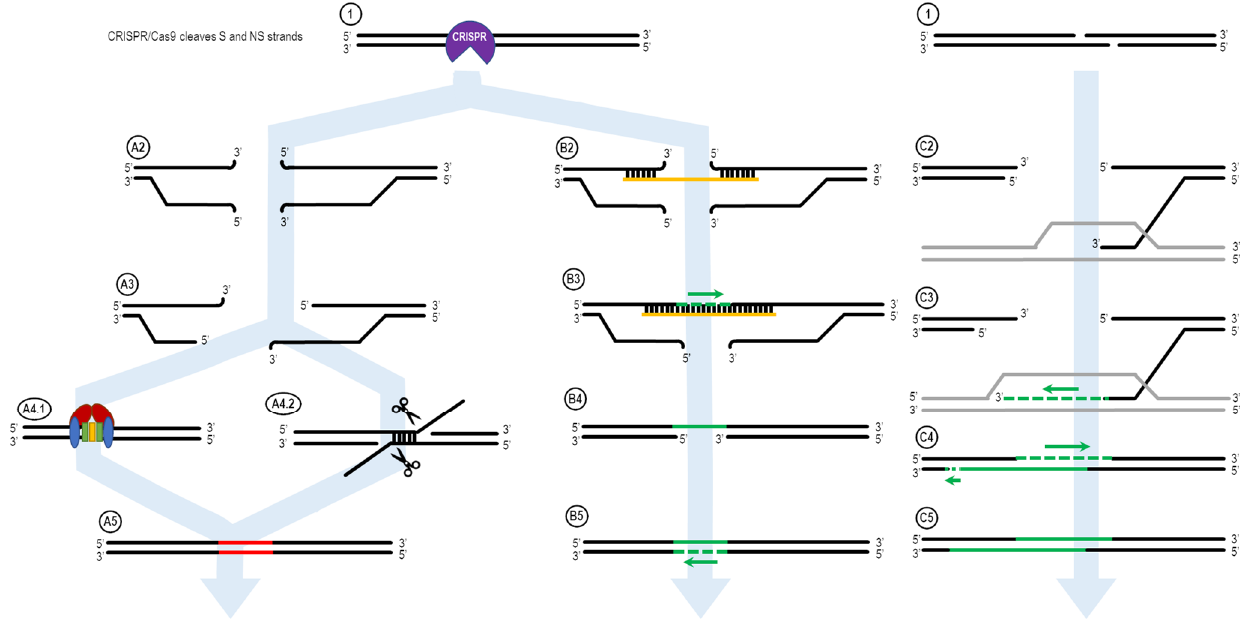
Figure 1. The ExACT DNA repair pathway, as outlined by Rivera-Torres et al. Upon CRISPR-mediated cleavage or breakage of the DNA ( 1 ), several possible pathways may be undertaken in order to facilitate DNA repair. In the absence of an ssODN oligo, or if the ssODN is not in the local vicinity of the broken DNA ends, the non-oligo repair pathway ( A2 – A5 ) is used. The CRISPR-Cas complex dissociated from the DNA ends ( A2 ), and resection of the DNA ends may occur ( A3 ). Then, either nonhomologous end joining (NHEJ, A4.1 ) or microhomology-mediated end joining (MMEJ, A4.2 ) occurs to repair the broken DNA ends. This results in an indel in the resulting DNA product, as bases are added or deleted via NHEJ and MMEJ. In the presence of an oligo, the ExACT pathway is undertaken ( B2 – B5 ). The oligo bridges both sides of the broken DNA ends ( B2 ) and facilitates synthesis-driven repair on one strand ( B3 ). The oligo then dissociated from the repaired DNA strand ( B4 ), so the repaired strand can in turn be used as a repair template for a second synthesis-driven repair event on the other DNA strand ( B5 ). This results in repair containing added, deleted or altered sequence information from the repair template ssODN. In the presence of a homologous gene, synthesis-dependent strand annealing can occur. One 3 ′ -end on either end of the DNA break interrogates the homologous gene and forms a D-loop ( C2 ). The 3 ′ -end is extended via DNA synthesis, expanding the D-loop ( C3 ). After a period of extension, the newly-lengthened 3 ′ -end dissociates from the homologous gene, and binds to its complementary sequence on the other end of the DNA break—bridging the gap ( C4 ). Further DNA synthesis fills in the remaining bases according to their respective complementary sequences ( C5 ).